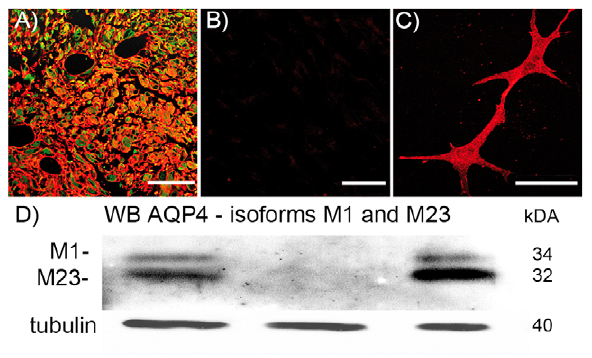
Figure 2. Immunoreactivity against AQP4 (red) and GFAP (green). (A) In human glioblastoma tissue AQP4 (red) shows an intensive staining whereas in primary cell culture of this glioblastoma AQP4 could not be detected (B). (C) Primary cell culture of astrocytes stained for AQP4. (D) Immunoblot against AQP4; the lower band (32 kDA) represents the AQP4 isoform M23 and the upper band (34 kDA) the isoform M1. Tubulin was used as loading control for these samples (40 kDA). The western blot is positive for AQP4 in the glioblastoma tissue (left lane), whereas the primary glioma cell cultures were negative (middle). Primary mouse astrocytes are positive for AQP4 (right lane). The M23-AQP4 isoform always shows a stronger band than the M1 isoform.